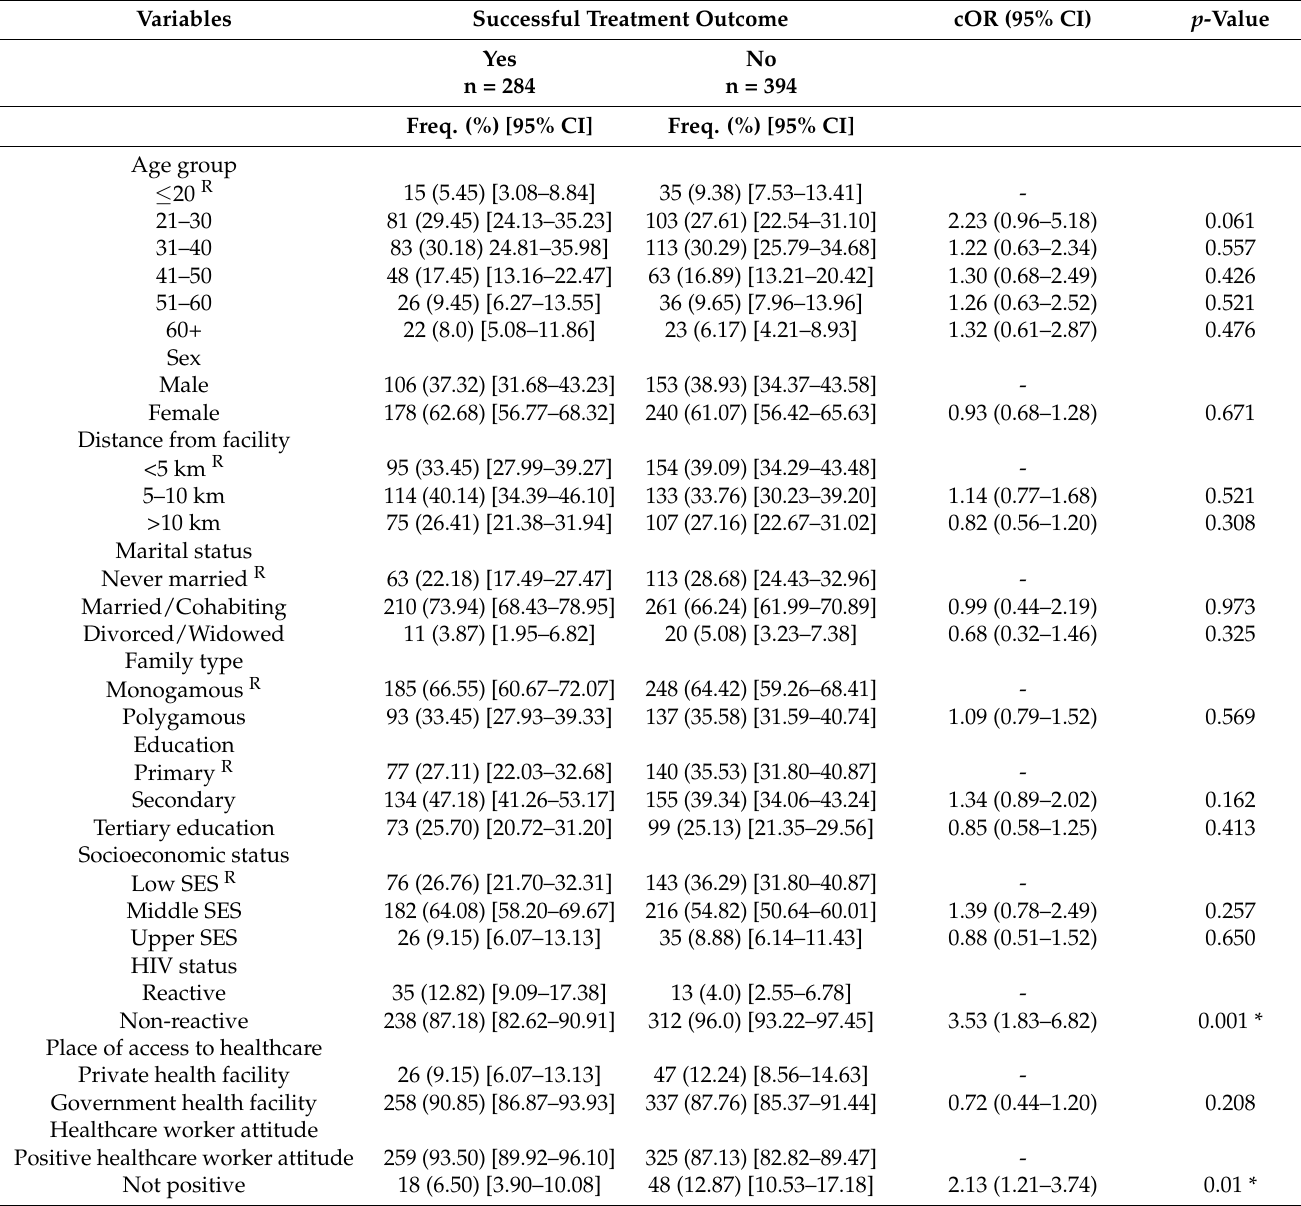
Table 4. Factors associated with the number of TB treatments received among the respondents stratified by treatment outcome using bivariate logistic